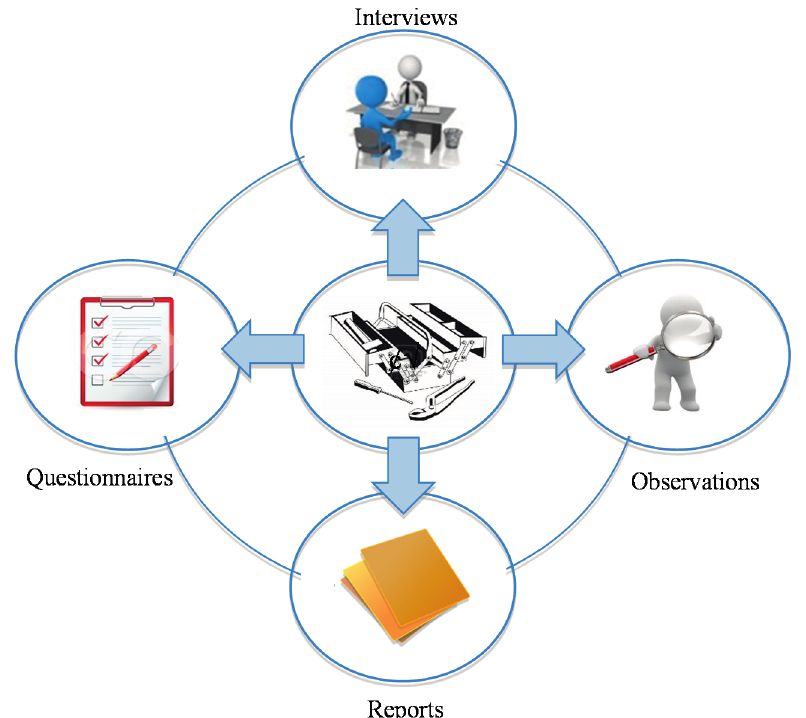
Figure 10. Data-gathering